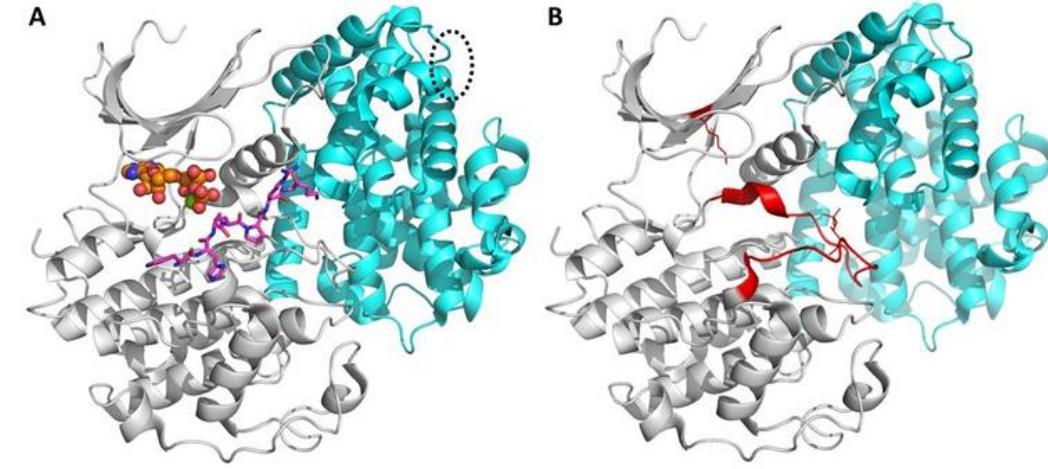
Figure 1. Example of spatial structure of complex between PK, ATP, peptide substrate, and a regulatory protein (based on PDB 1QMZ). ( A ) PK (CDK2) is shown as grey cartoon, regulatory protein (cyclin A) as cyan cartoon, MgATP as colored spheres, and substrate as colored sticks. The distant site on cyclin A responsible for recognition of longer protein substrates is indicated with black dotted oval. ( B ) The same complex as in ( A ), but MgATP and substrate peptide are hidden for clarity. The catalytically important Lys residue (mentioned in text) and activation loop are highlighted in red and Lys and phospho-Thr in the activated loop are shown as lines.